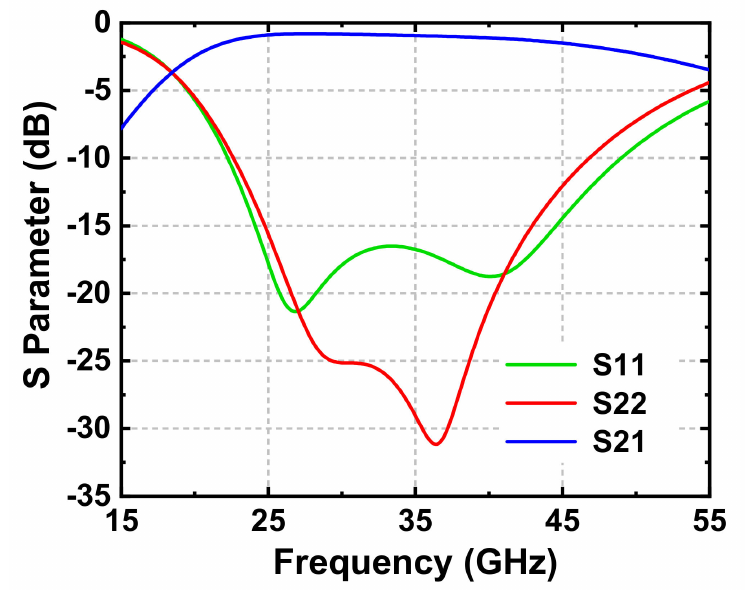
Figure 11. Simulated S-parameters of a passive